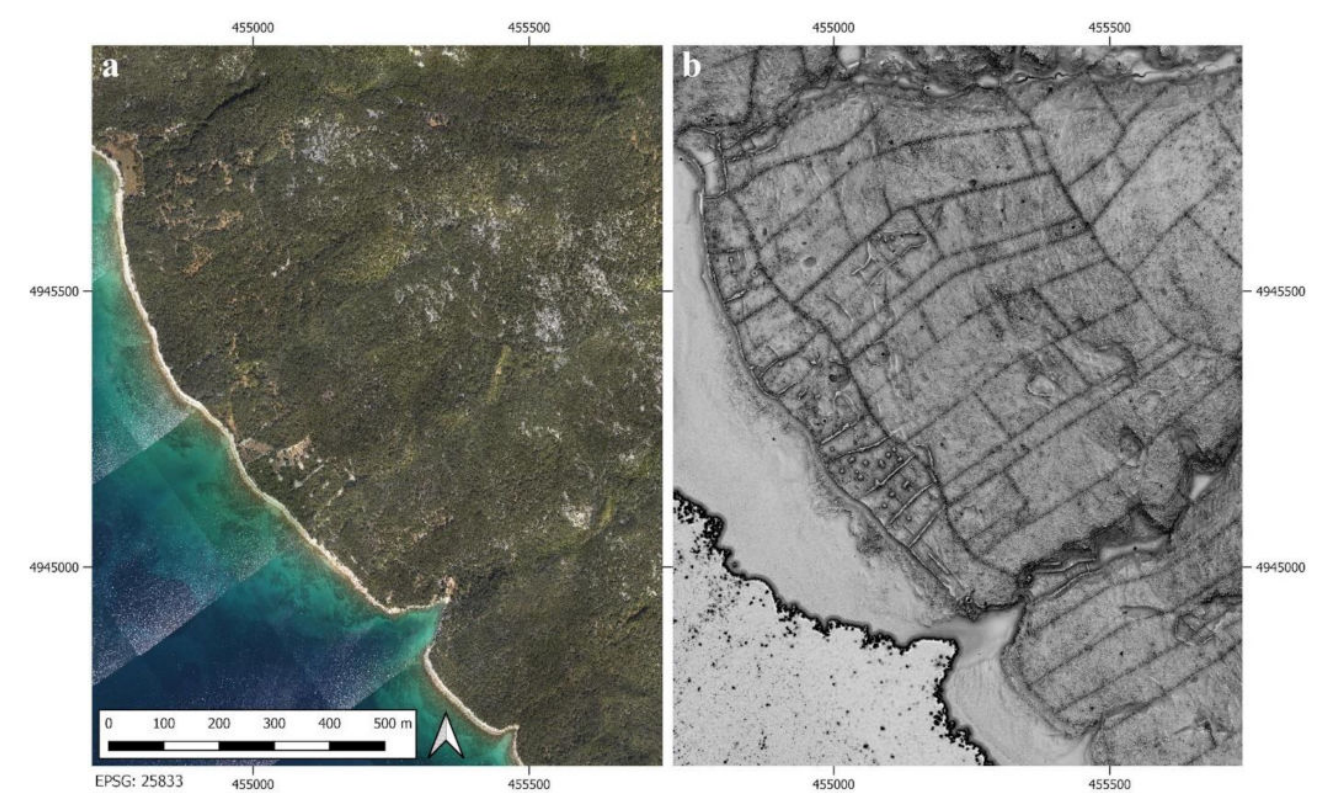
Figure 4. ( a ) Orthophotograph of a part of Punta Križa showing the extent of maquis, where agricultural use has almost stopped. The photograph was produced simultaneously with ALS data acquisition (March 2012). ( b ) The digital terrain model of the same area reveals a network of dry stone walls that evidence intensive former use. Note that the green laser penetrated the water to a depth of 10 m allowing the sub-surface terrain to be modelled to this depth (visualization: cVAT, i.e., hillshading from three directions, slope, positive openness and sky-view factor—see